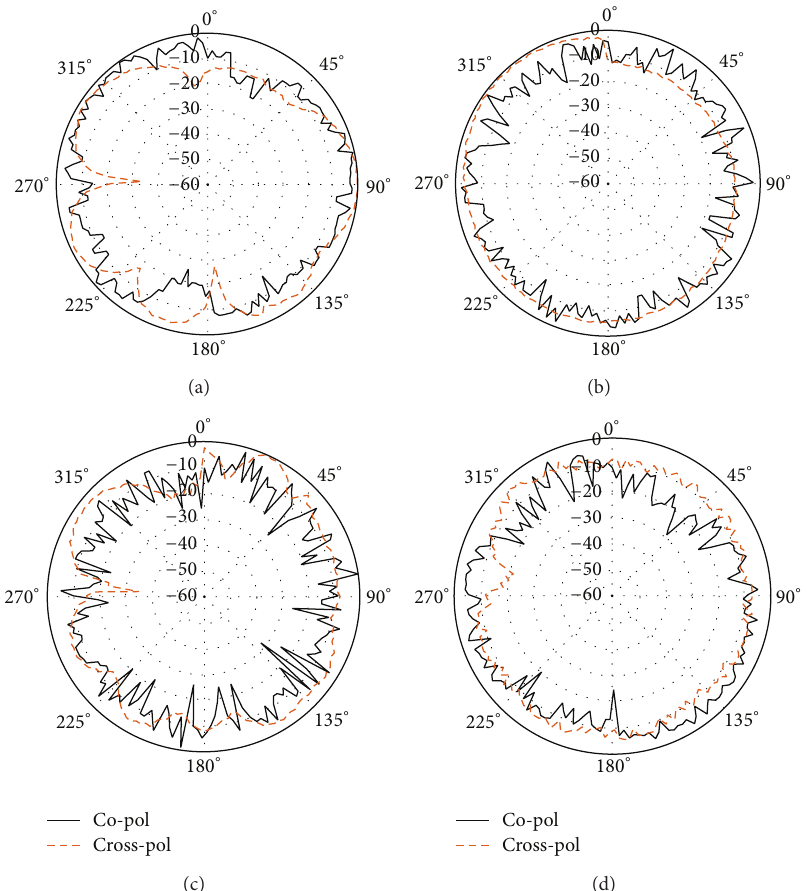
Figure 13: Measured normalized radiation pattern of the antenna at (a) 5.7 GHz E-plane, (b) 5.7 GHz H-plane, (c) 7.6GHz E-plane, and (d) 7.6 GHz H-plane.